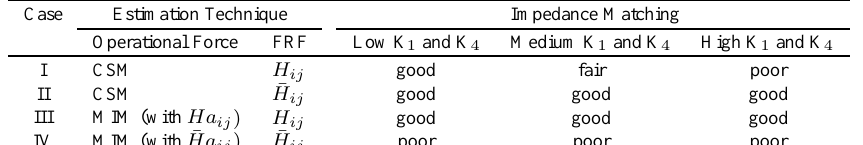
Table 2 Comparison of the estimation techniques with the impedance matching